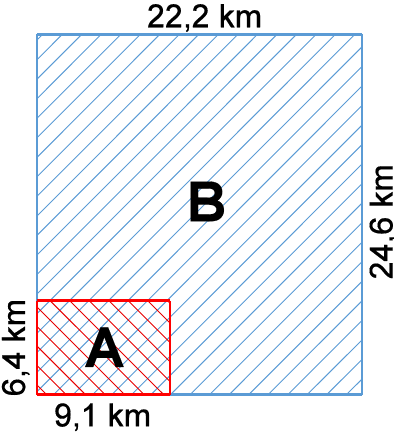
Figure 1. Dimensions and mutual position of model data areas: ( A ) 1:10 000 data area, ( B ) 1:50 000 data area.